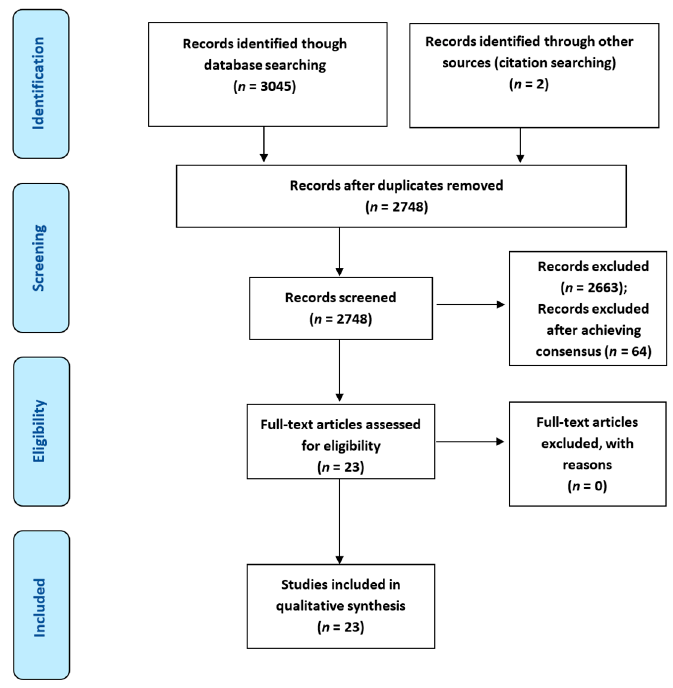
Figure 1. PRISMA Flowchart for the Rapid Review.